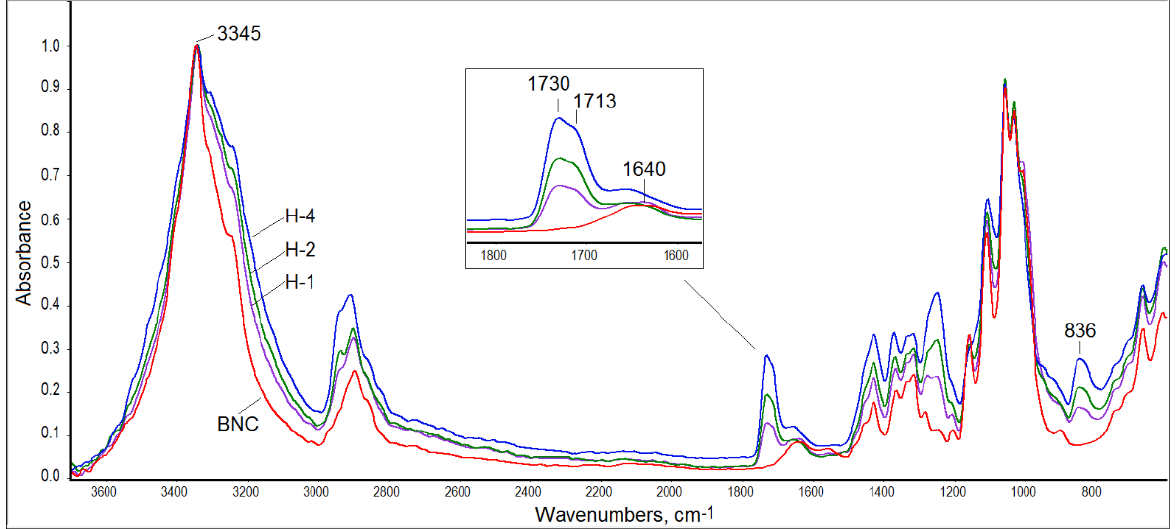
Figure 2. ATR-FTIR spectra of BNC and BNC/PVA composites obtained by the in-situ method (the insert shows an enlarged spectrum fragment in the carbonyl range).